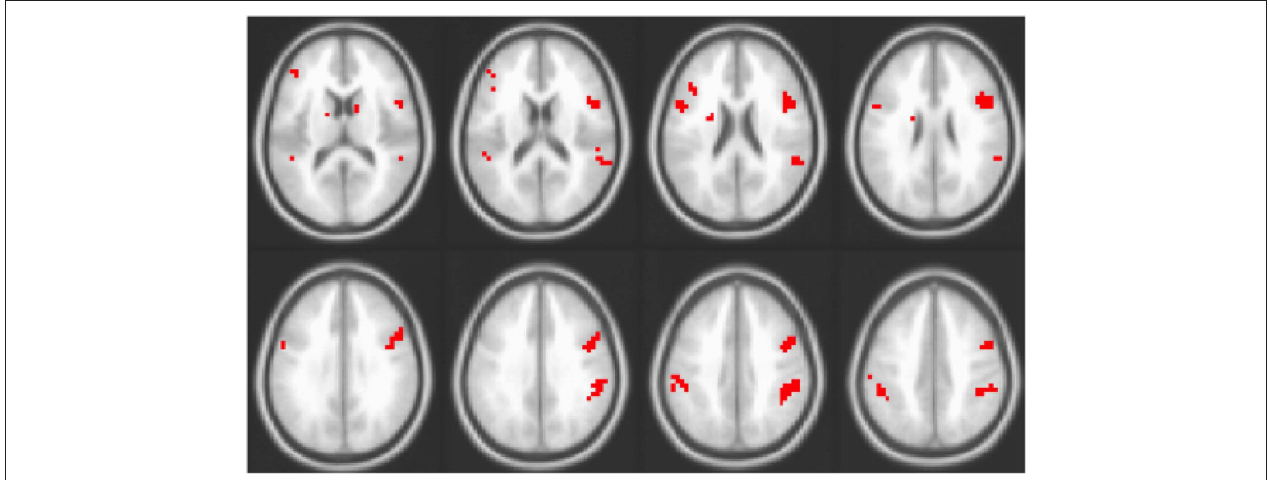
FIguRe 4 | Overlap of areas with reliable effects in the adaptation study (contrast of D in Figures 2 and 3 ). Areas in red are those where older adults showed no adaptation to location in the adaptation experiment and greater activity for repeated location targets in the working memory